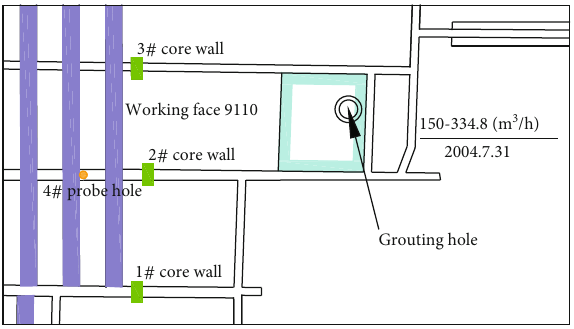
Figure 2: Water inrush position of 9110 working